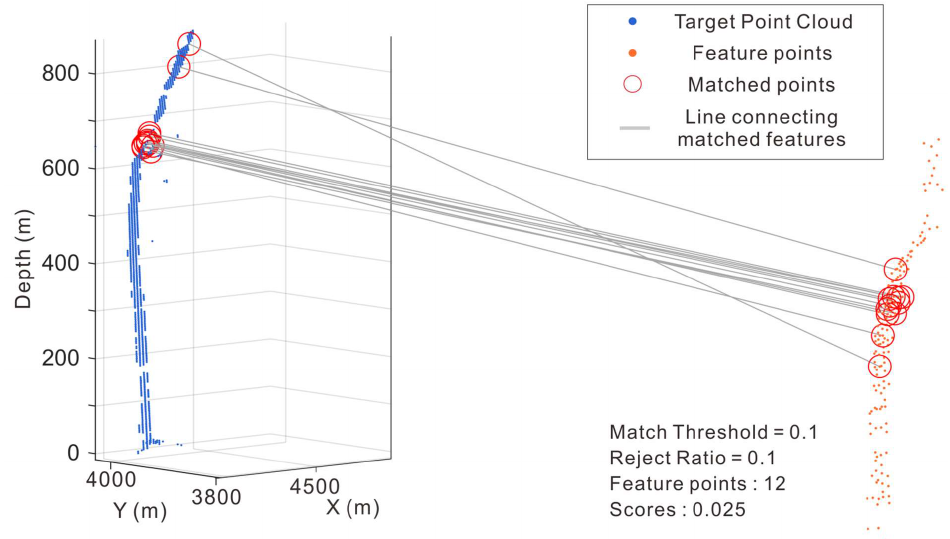
Figure 11. Schematic diagram of plume point cloud detection. The figure shows the matching process between the point cloud to be detected (blue dots) and the plume model feature points (red dots): the matching feature points (circled in red) are connected with gray straight lines, the detection threshold is set to 0.1, and the final score is 0.025, indicating it is a gas plume, and the same threshold is used to detect the point cloud in the subsequent detection.